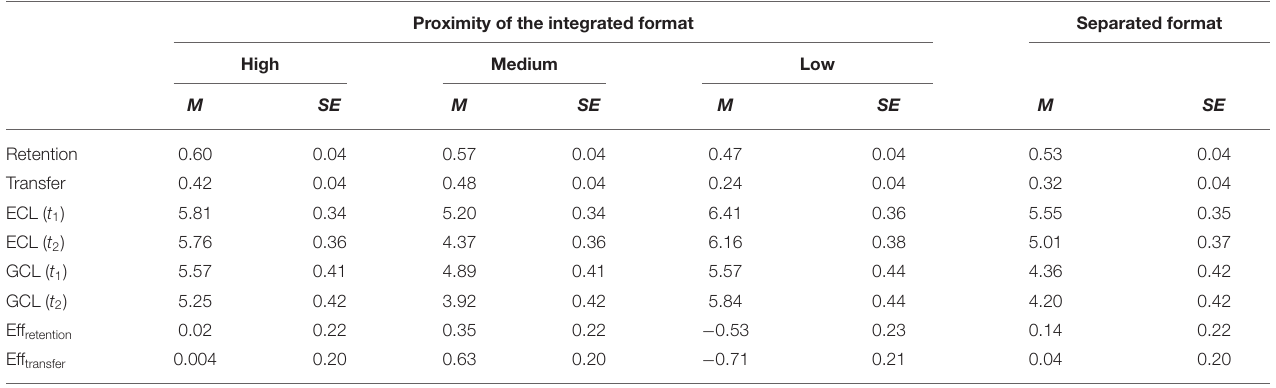
TABLE 1 | Descriptive data for all measures of Experiment 1. Proximity of the integrated format Separated